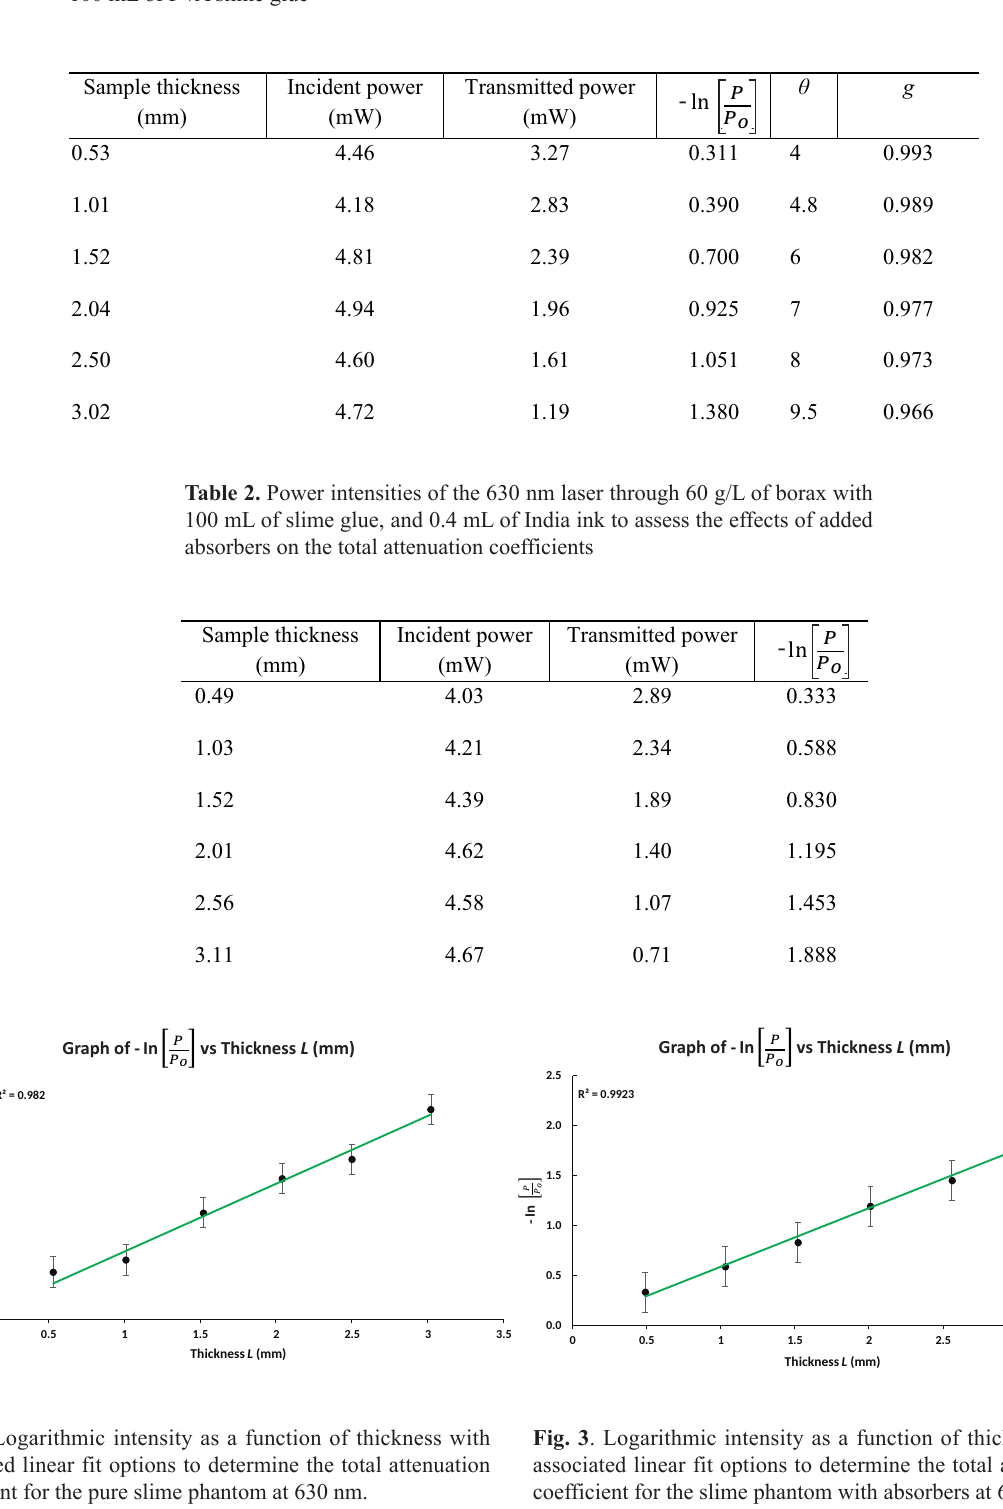
Table 1. Power intensities of the 630 nm laser through a mixture of 60 g/L concentration of borax and